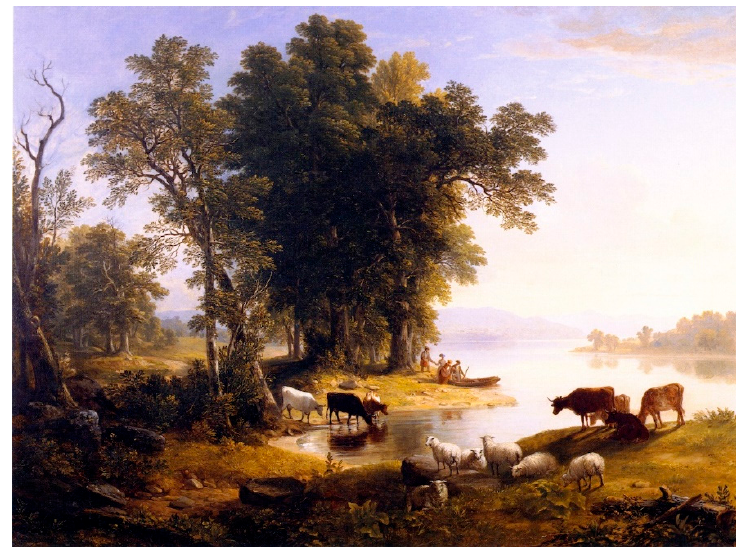
Figure 1. Asher Brown Durand, American, 1796–1886. The Hudson River Looking. Towards the Catskills , 1851. Oil on Canvas. 53 × 69 ¼ inches. Fenimore Art Museum. Cooperstown, New York. Gift of Stephen C. Clark. NO391.1955. Photograph by Richard Walker.